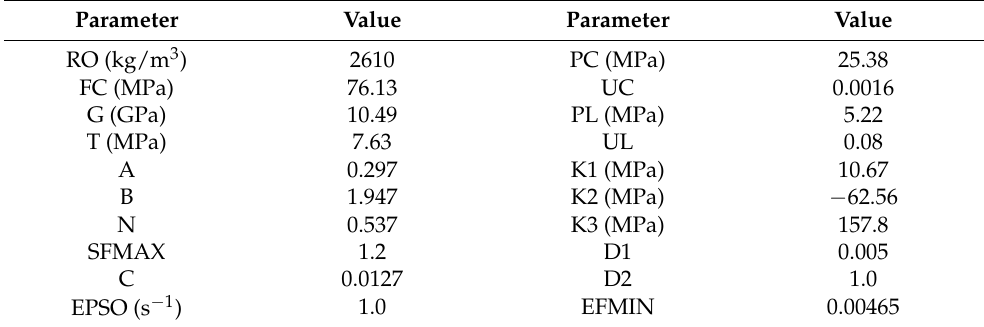
Table 8. The parameters of the HJC model for